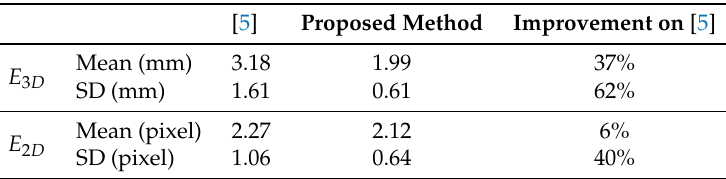
Table 2. The numerical improvements between our system and [5] on the Handy/Teaser sequence. We consider the the mean value and the standard deviation (SD) of the E 3 D and E 2 D .